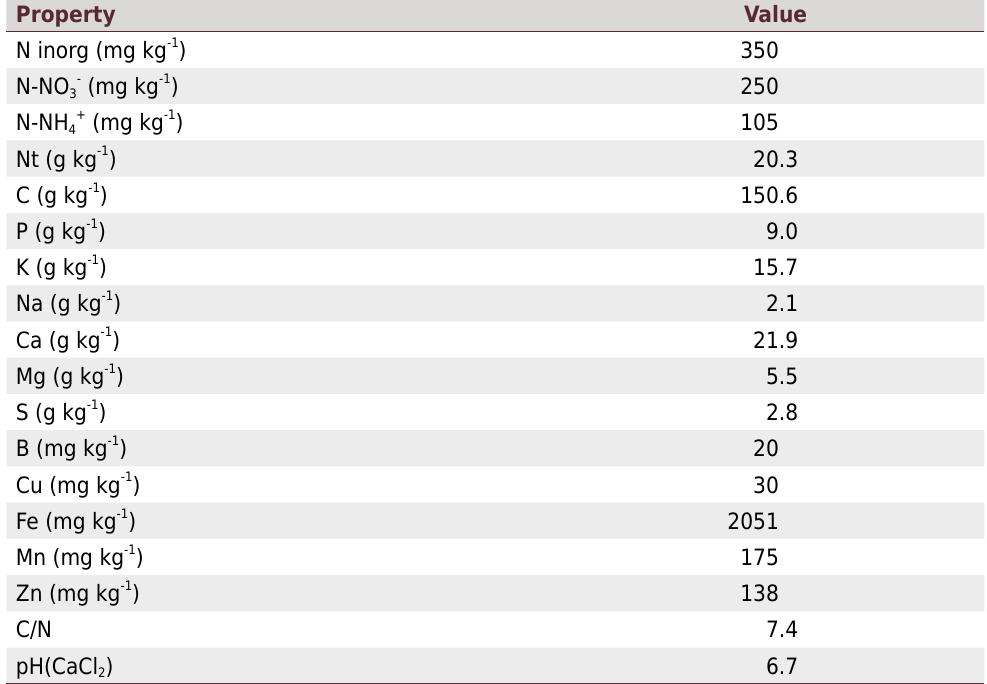
Table 2. Chemical properties of the organic